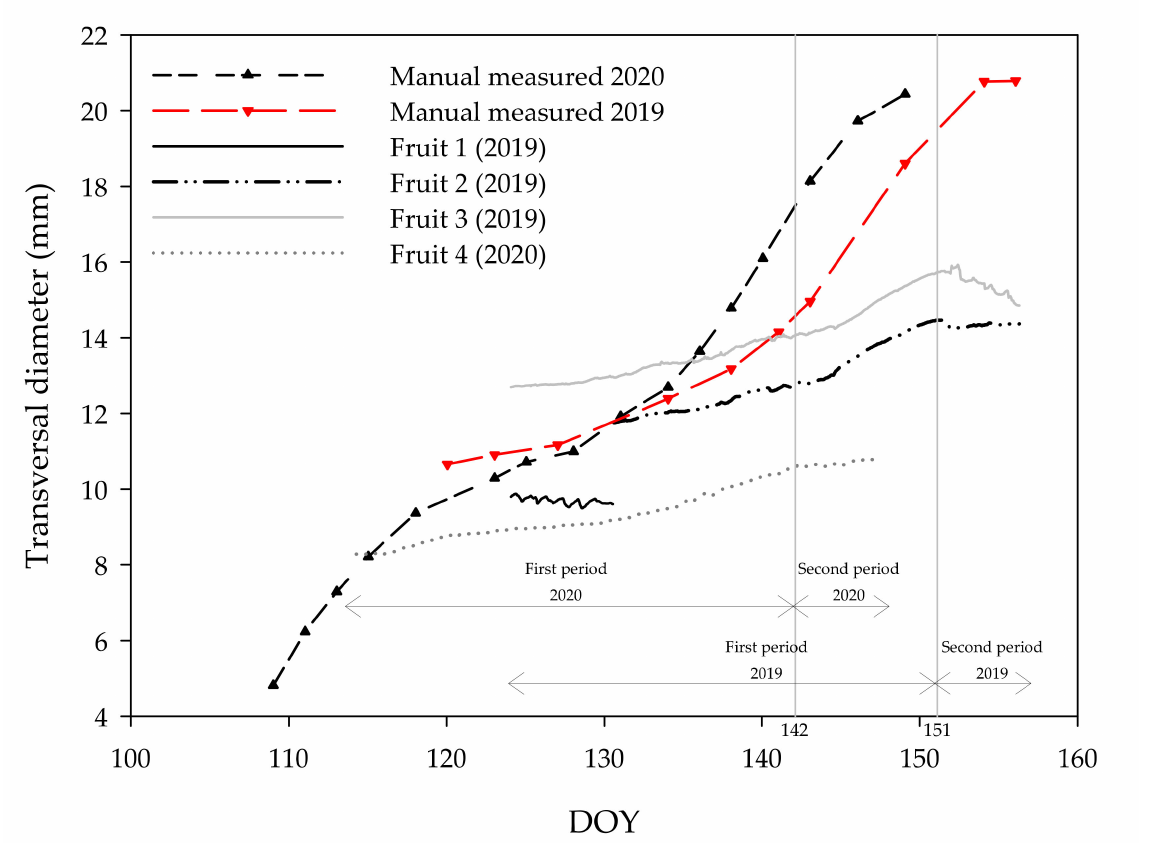
Figure 2. Data interpolation of the 50 labeled fruit in 2019 (manually measured 2019) and 2020 (manually measured 2020); fruit 1 is related to extensometer 1 in 2019; fruit 2 is related to extensimeter 1 in 2019; fruit 3 is related to extensometer 2 in 2019; fruit 4 is related to extensometer 1 in 2020. The first period of the study was from DOY 131 to 150 in 2019 and from DOY 114 to 141 in 2020. The second period of the study was from DOY 151 to 155 in 2019 and from DOY 142 to 146 in